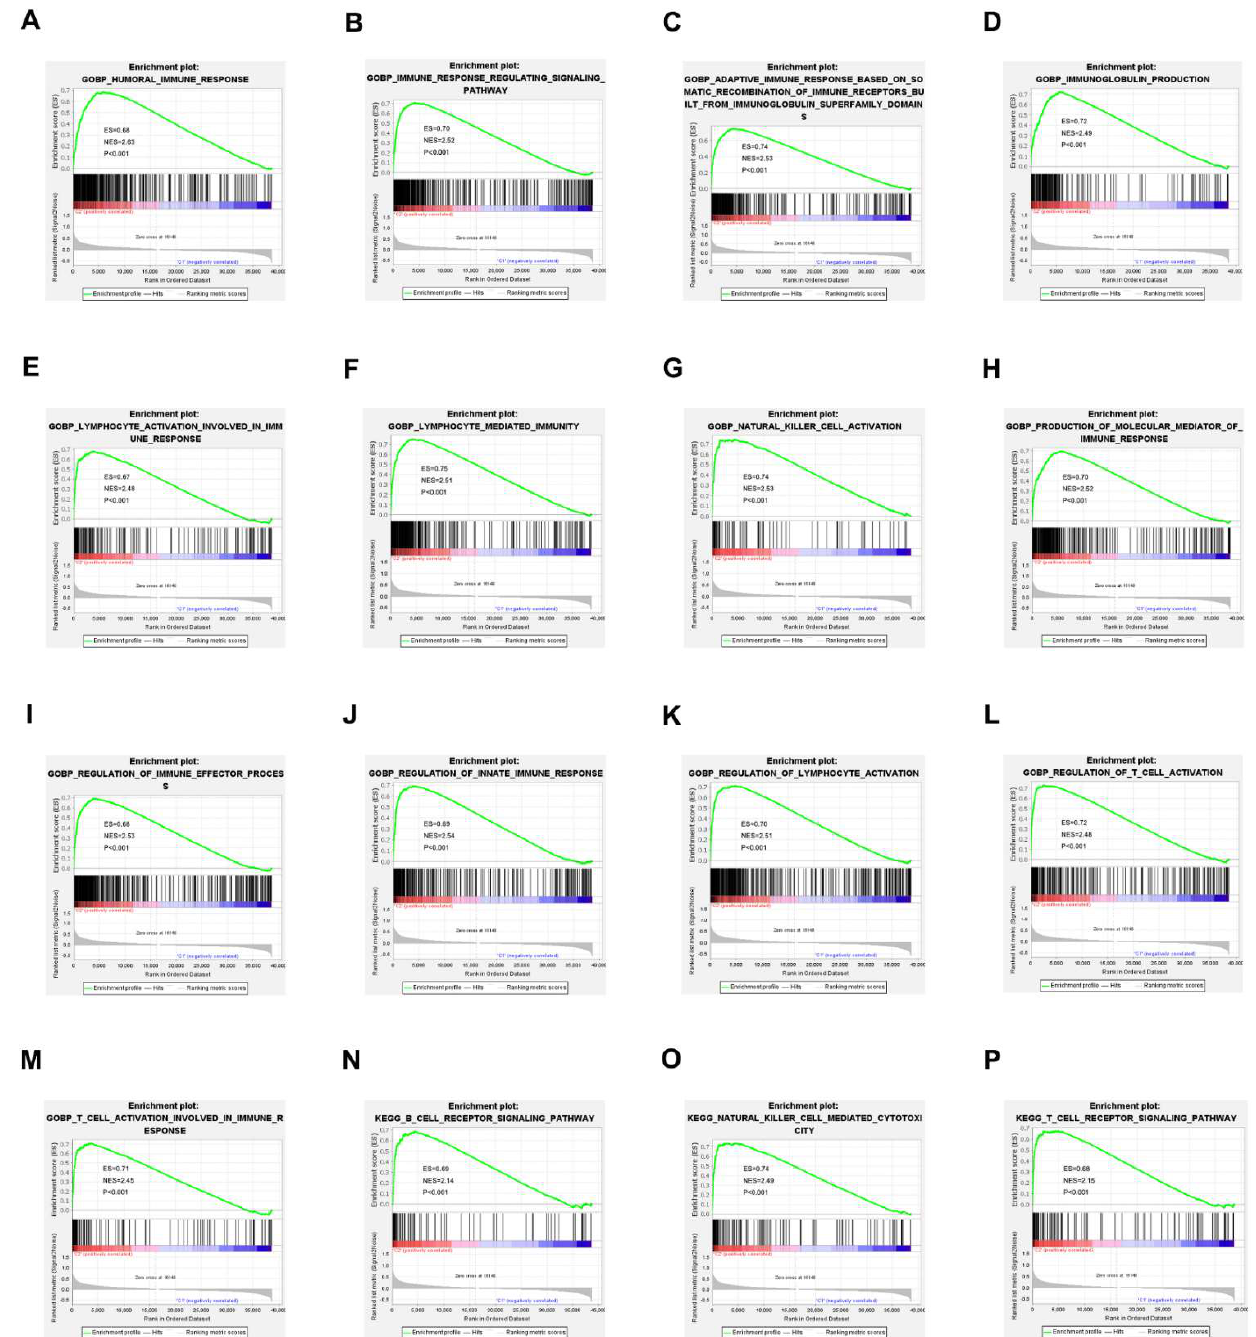
Figure 4. GSEA shows that BC cluster 1 is enriched for various immune-response processes